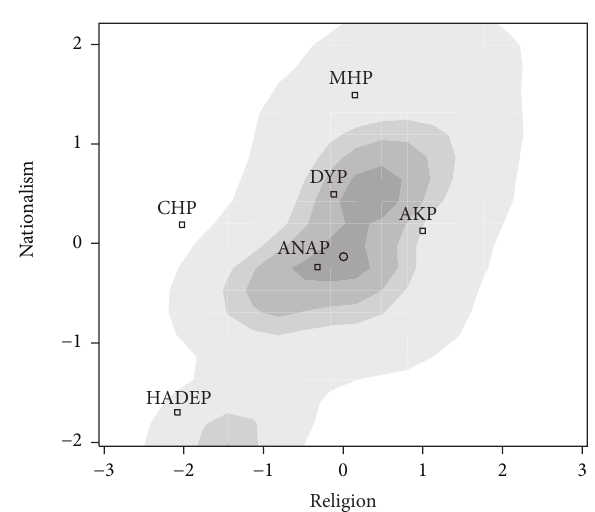
Figure 8: Party positions and voter distribution in Turkey in 2002.